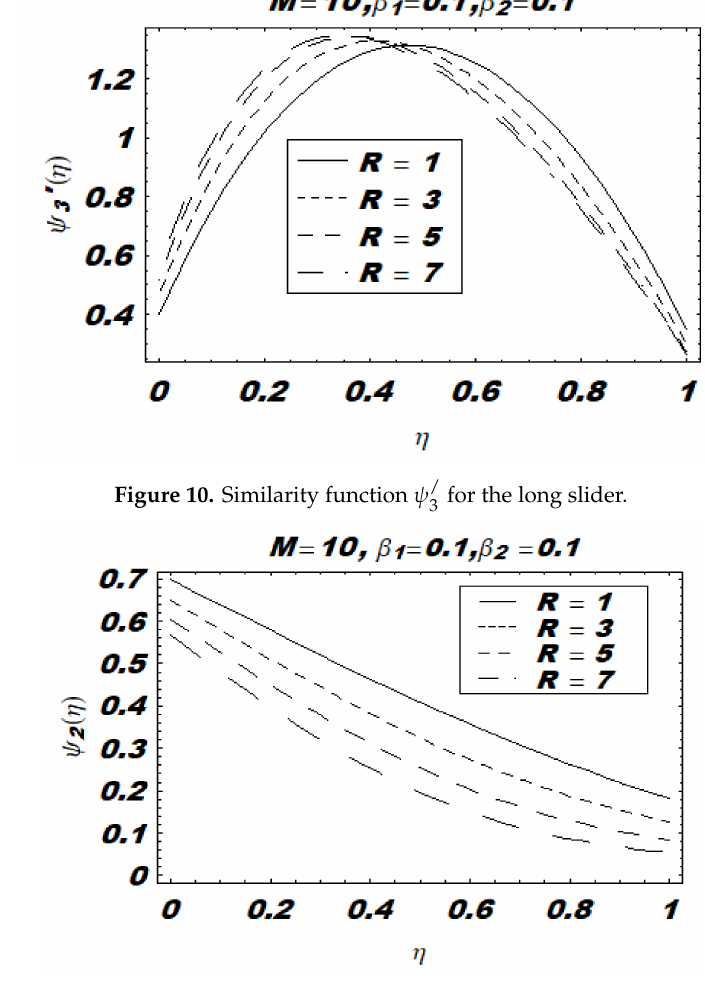
Figure 11. Similarity function ψ 2 for the long slider.